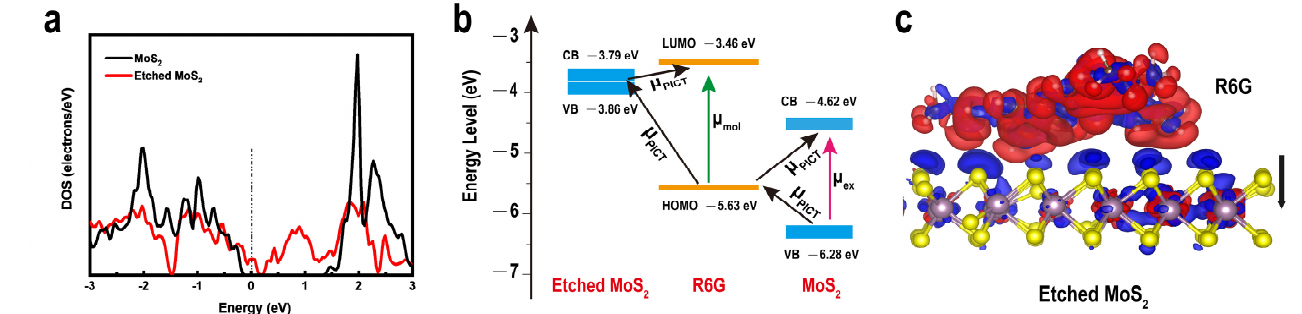
Figure 4. ( a ) Density of states of CVD grown MoS 2 and etched monolayer MoS 2 . ( b ) Energy level diagram and charge transfer transitions in the diagram comparing the charge-transfer pathways in R6G/MoS 2 and R6G/etched MoS 2 -MoS 2 . ( c ) Side views of the electron density difference isosurface for the R6G molecule absorbed on etched monolayer MoS 2 .